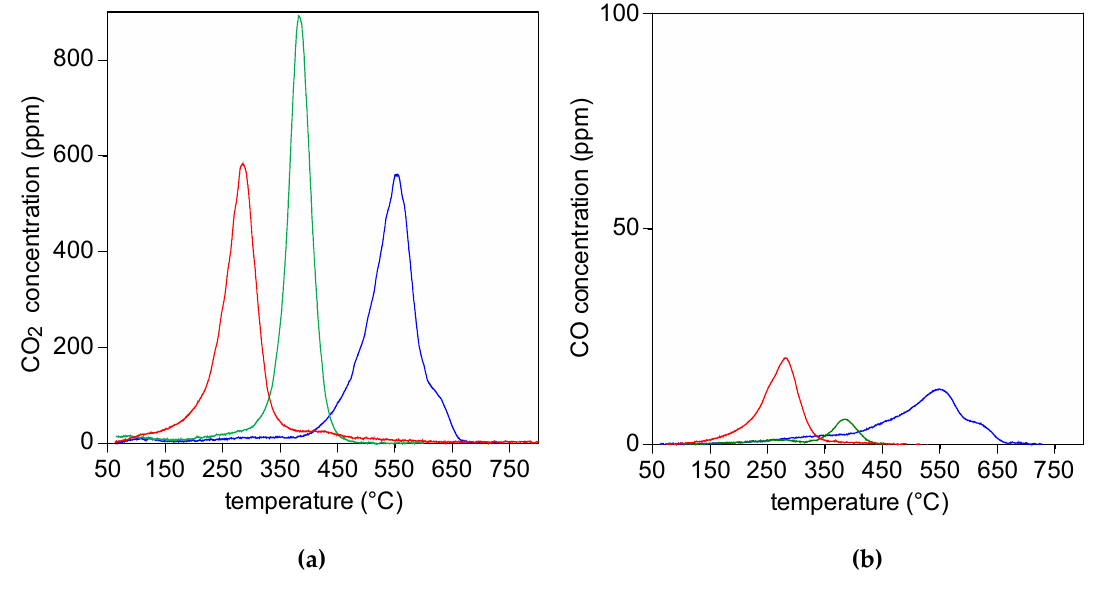
Figure 3. Temperature programmed oxidation (TPO) profiles of ( a ) CO 2 and ( b ) CO evolved from CZ/C mixtures at different mixing condition: CZ(l) (blue), CZ(t) (green) and CZ(m) (red).